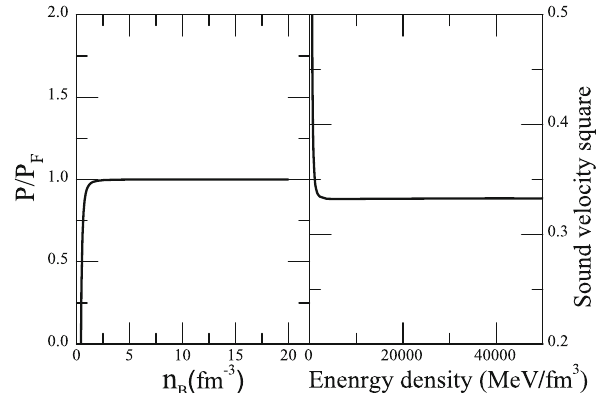
Fig. 6 Left panel: The ratio of the pressure with DI-245 to the pressure for free fermi gas at zero magnetic field as a function of baryon density. Right panel: the sound velocity square within DI-245 at zero magnetic field as a function of the energy density within